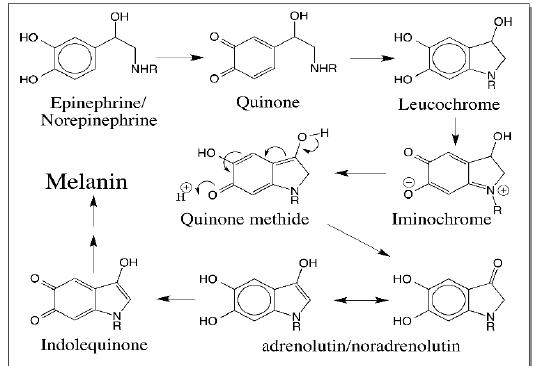
Figure 20. Oxidation of epinephrine and norepinephrine. Oxidation of epinephrine (R = methyl group) and norepinephrine (R = H) results in their corresponding quinones. These quinones also cyclize and get oxidized to form iminochromes. The iminochromes upon conversion to quinone methide easily isomerize and produce adrenolutin/noradrenolutin, which will also form melanin pigment eventually.